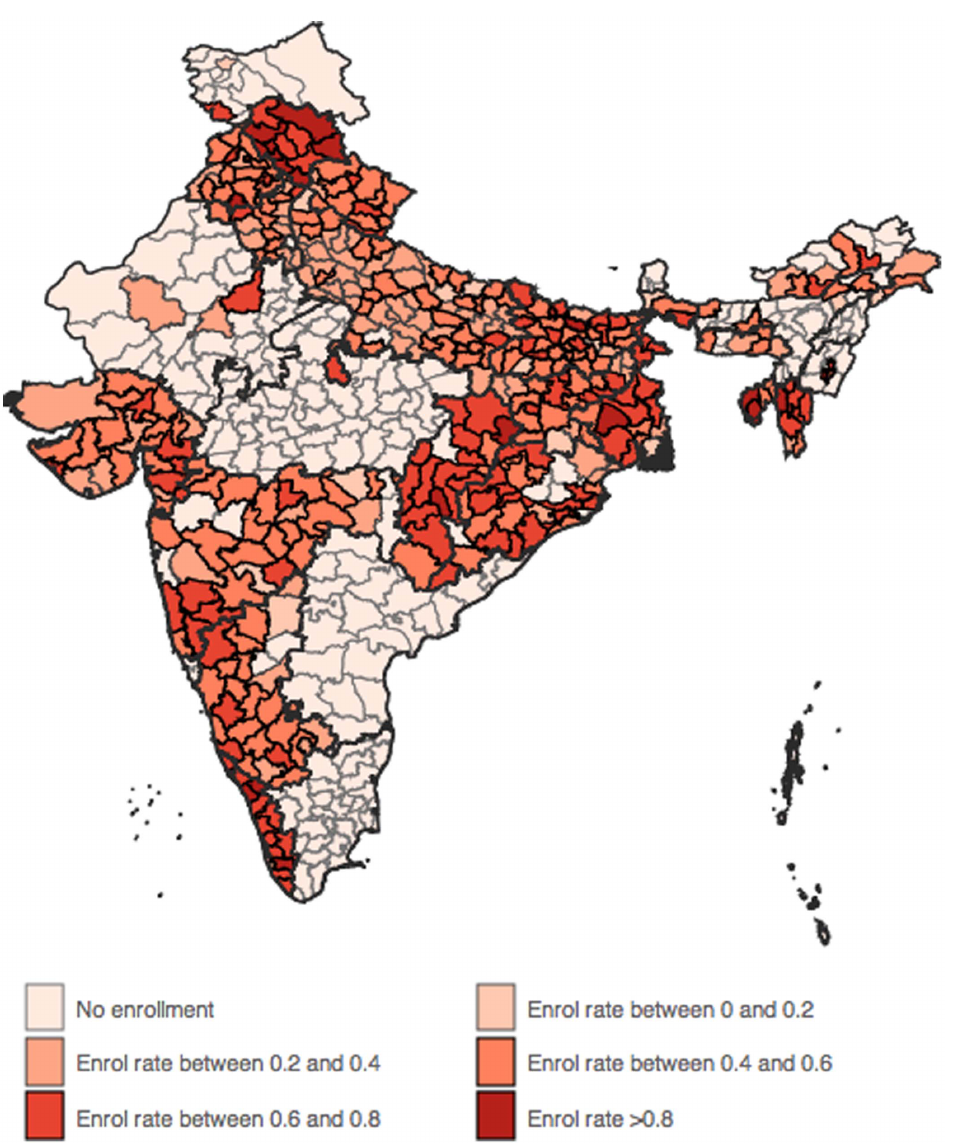
Figure 2. Variation in RSBY enrolment rates. Source: RSBY website (www.rsby.gov.in) downloaded on 22 May 2012. Map created using GADM data. www.gadm.org.